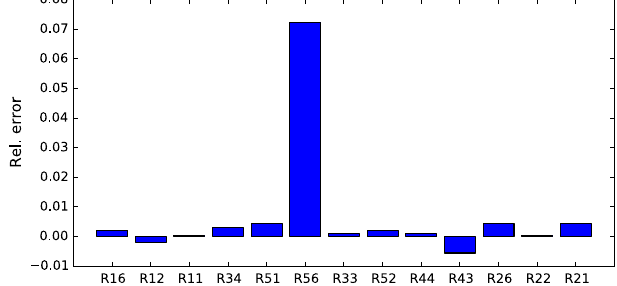
FIG. 1. Relative errors for various re -entries for 4 slices of a single CFM with quadrupole and sextupole component against the Lie-transformation coefficients. Those errors which are zero are not shown.